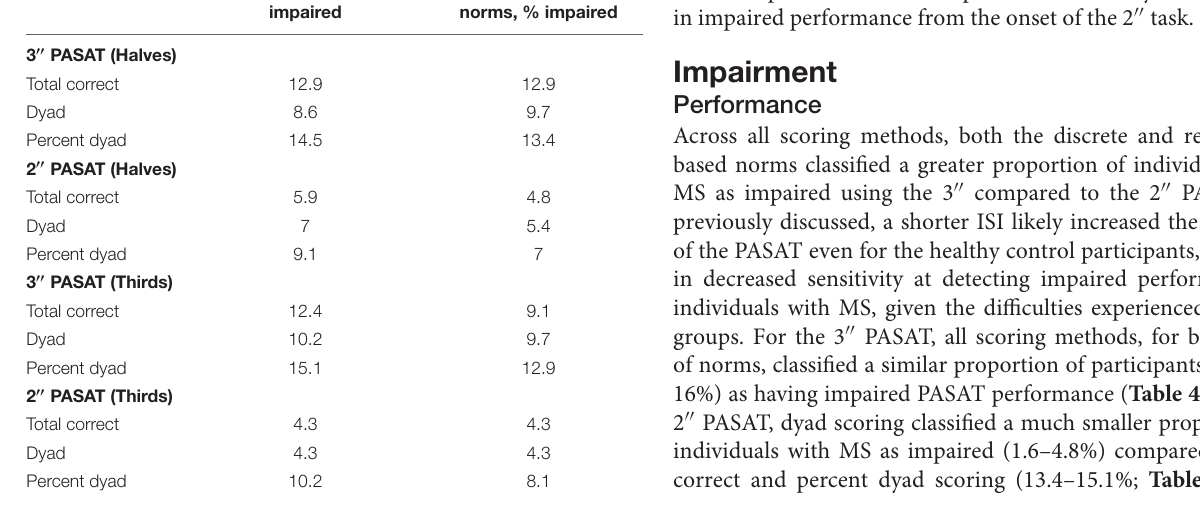
Regression-based impaired norms, %